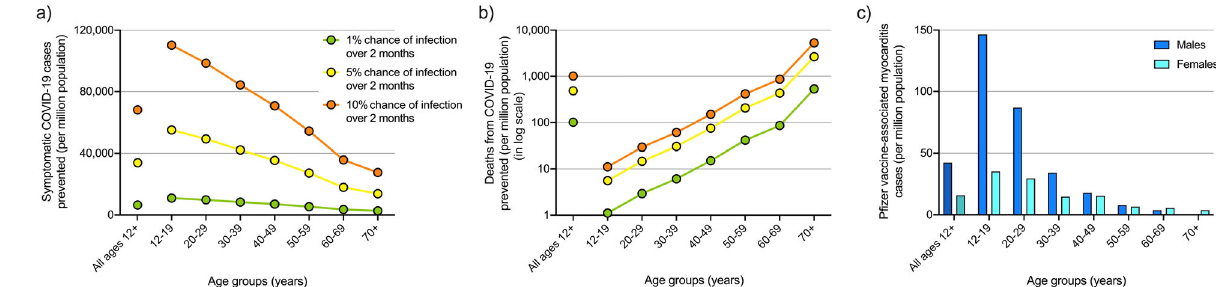
Fig. 3 Comparison of estimated P fi zer vaccine-associated myocarditis cases to symptomatic COVID-19 cases and deaths prevented. Estimated COVID-19 cases ( a ) and deaths ( b ) (in log scale) prevented by age group over 2 months per million population if 5% of population of ages ≥ 12 years had no doses, 5% had fi rst dose, 60% had two doses (evenly distributed over 0 to < 2, 2 to < 4 and 4 to < 6 months since second dose) and 30% had three doses of P fi zer COVID-19 vaccine if community transmission equivalent to 1% (green), 5% (yellow) and 10% (orange) chance of infection over 2 months. c Estimated cases of P fi zer COVID-19 vaccine-associated myocarditis over 2 months under the same vaccine coverage.